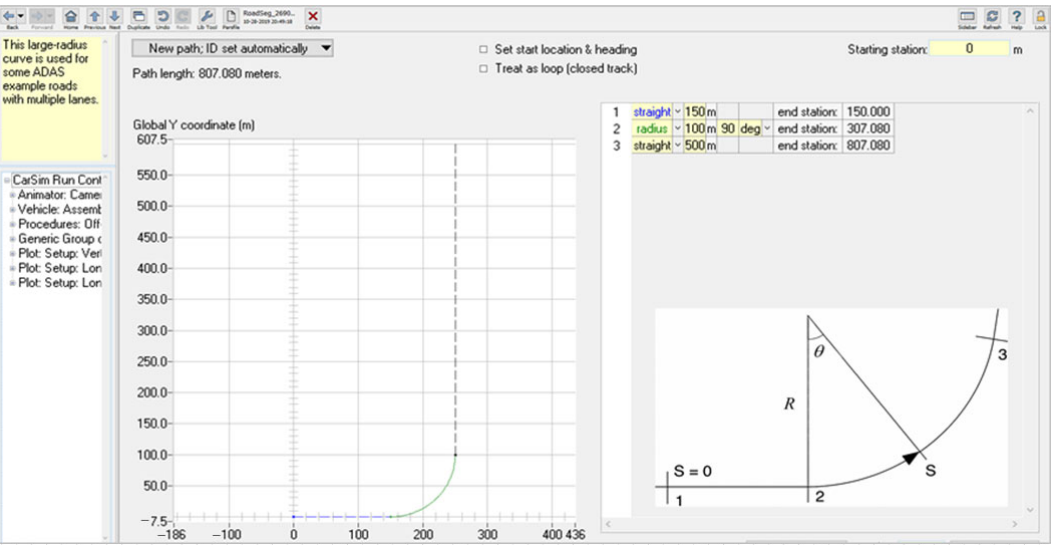
Figure 9. Reference travel route setting.